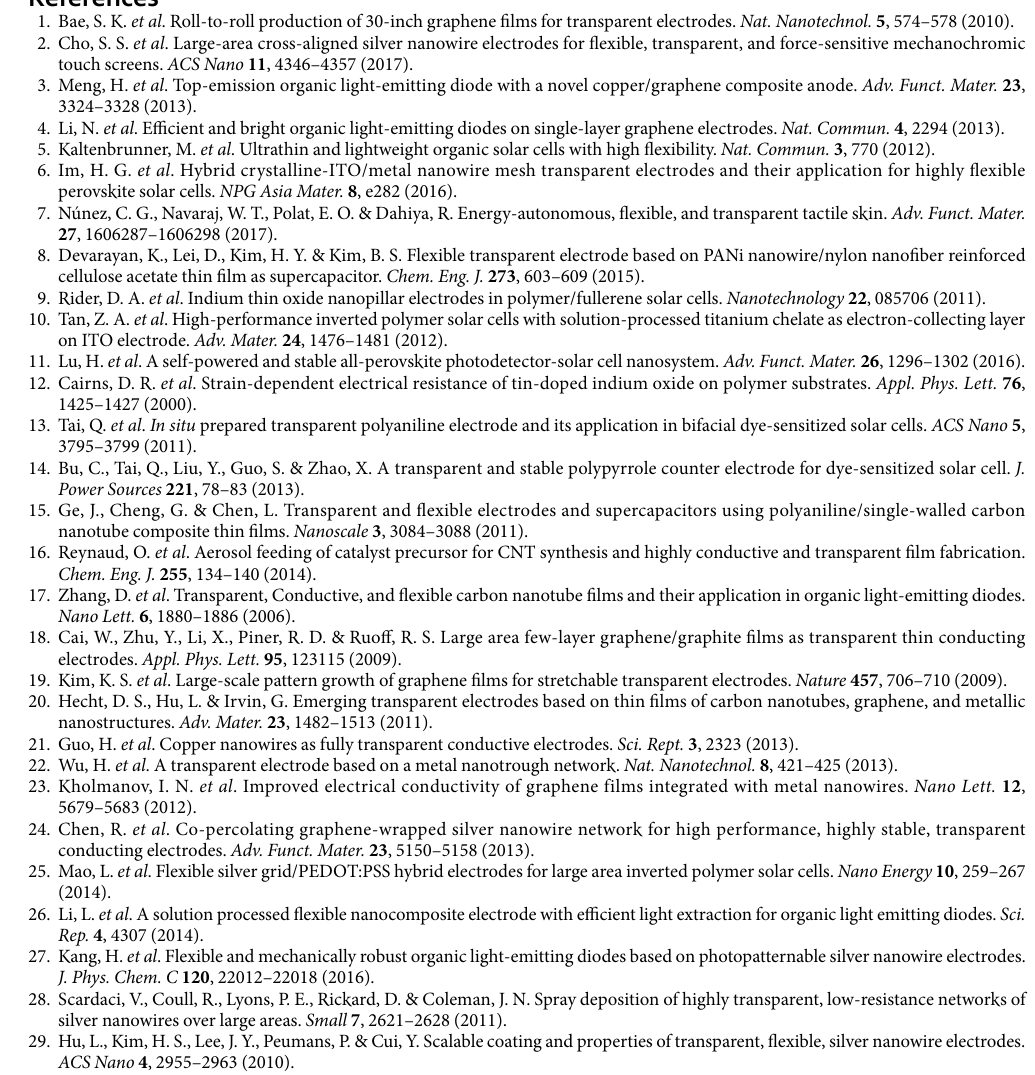
Figure 3f displayed the transmittance change of the NF-r-CA PDLC-based film with different bending cycles at various applied voltages. The transmittance change can be explained as Δ T/T o , where Δ T is the change in the transmittance value after bending test and T o indicates the initial value of transmittance. Under the applied volt- age of 24.24V rms , ITO PDLC films showed the swift increment of transmittance change in-between 50 and 100 cycles bending tests, whereas gradual trivial increment is noticed in the case of NF-r-CA PDLC films after each 100 cycles bending test till 500 cycles. The significant transmittance change for ITO PDLC film can be attributed to the absence of vertical electric field due to the ITO electrode fracture during the bending test. On the other hand, in the NF-r-CA PDLC film, the orientation of LC in the droplets is changed vertically along the applied electric field direction at 24.24 V rms even after each bending test (100, 200, 300, 400 and 500 cycles) due to the mechanical stability of NF-r-CA electrodes. This result demonstrates the excellent foldable stability of NF-r-CA PDLC films at an extreme bending radius of 1.5